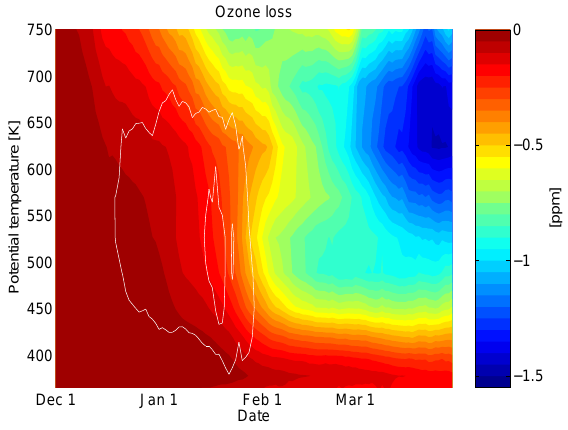
Fig. 8. Vortex-averaged ozone loss for the reference run as a func- tion of time and potential temperature. Difference between the mod- elled ozone and the passive ozone tracer averaged as in Fig. 1. The white contours show the time periods where the formation of NAT clouds (outer contour) and ice clouds (inner contour) was possible inside the